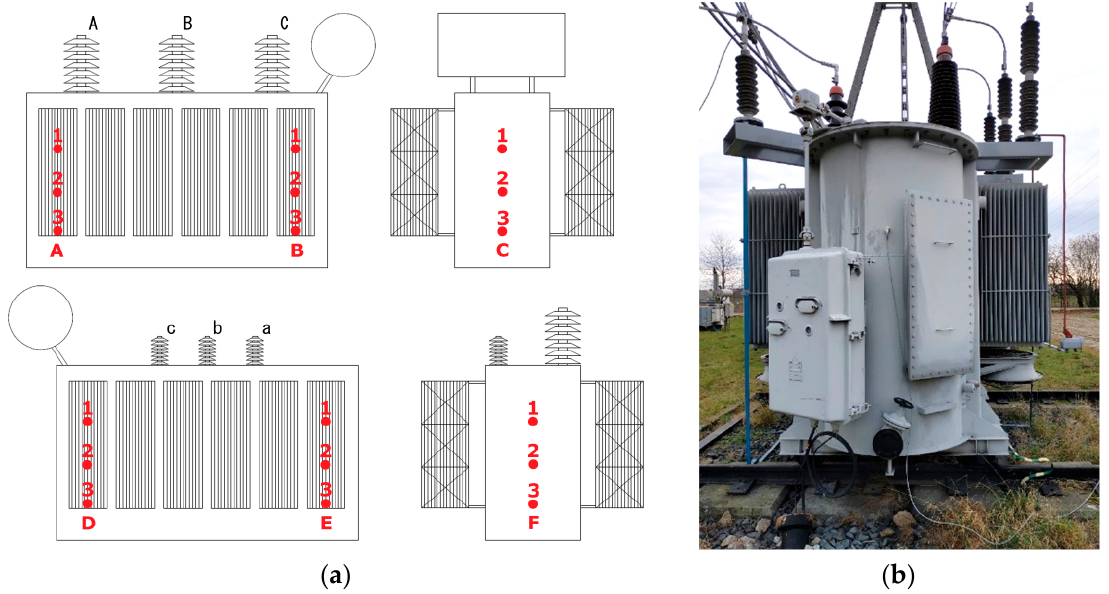
Figure 3. ( a ) Arrangement of measuring points on the tested transformers; ( b ) View of the transformer No. 4 with the sensor attached in F1 point.